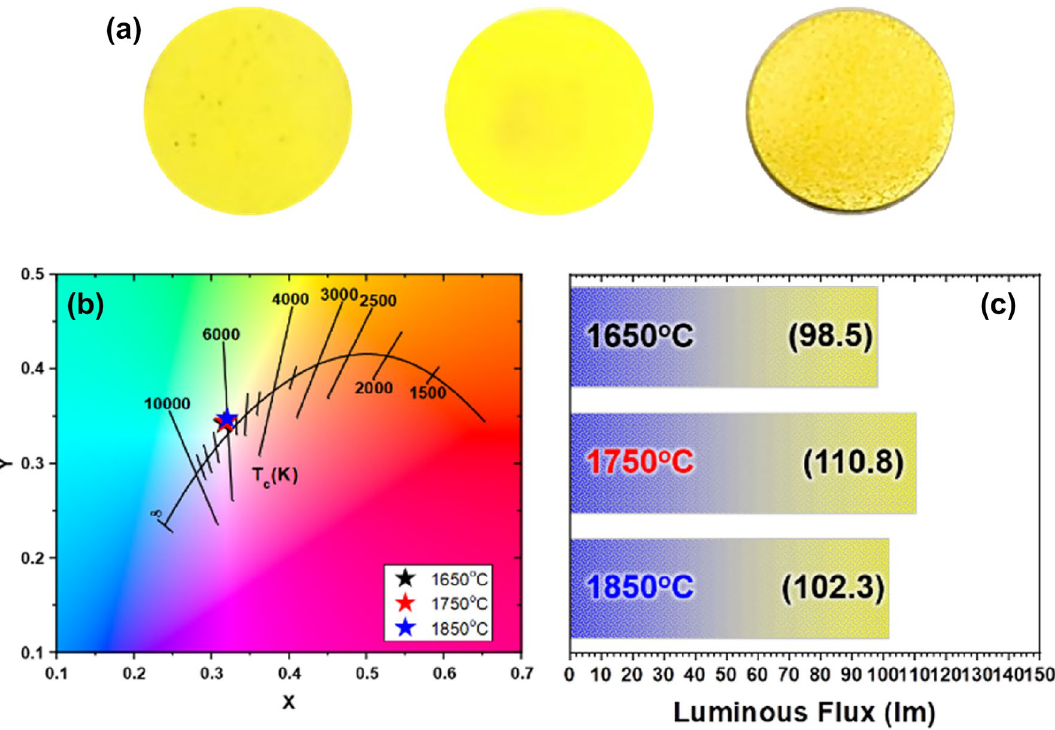
Figure 3. ( a ) Photographs of the CPs prepared by different sintering temperature based on HPF sintering (from left to right: 1650, 1750, and 1850 °C), SPS, and GPS). ( b , c ) CIE color coordinates and the luminous flux of CPs, respectively.